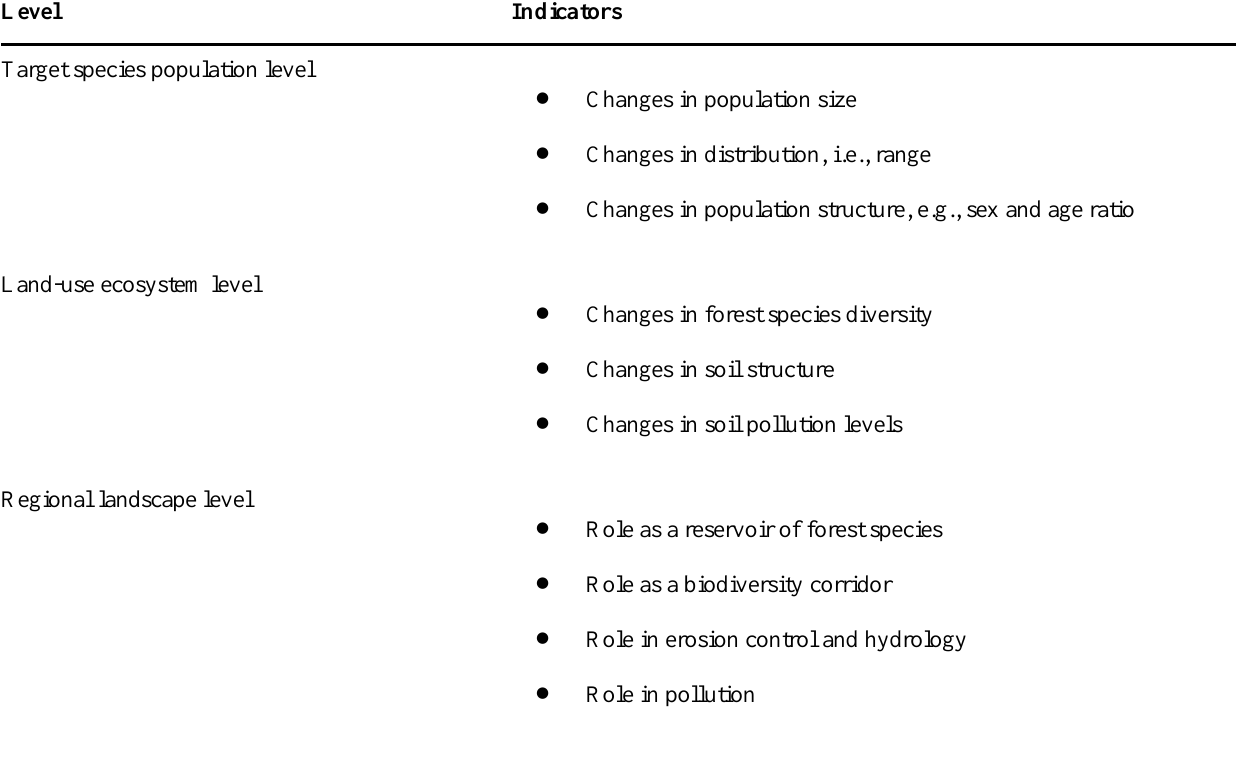
Table 2. Environmental